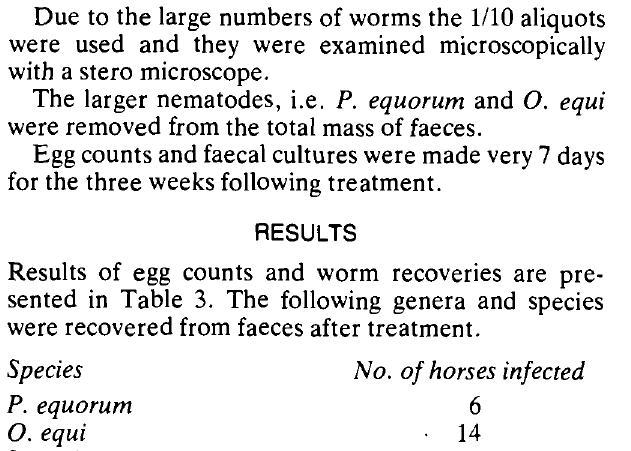
Table 3: MODIFIED CRITICAL TEST IN HORSES. WORMS EXPELLED IN FAECES AFTER TREATMENT WITH A SINGLE DOSE OF FENBENDAZOLE AT 10 mg/kg LIVE